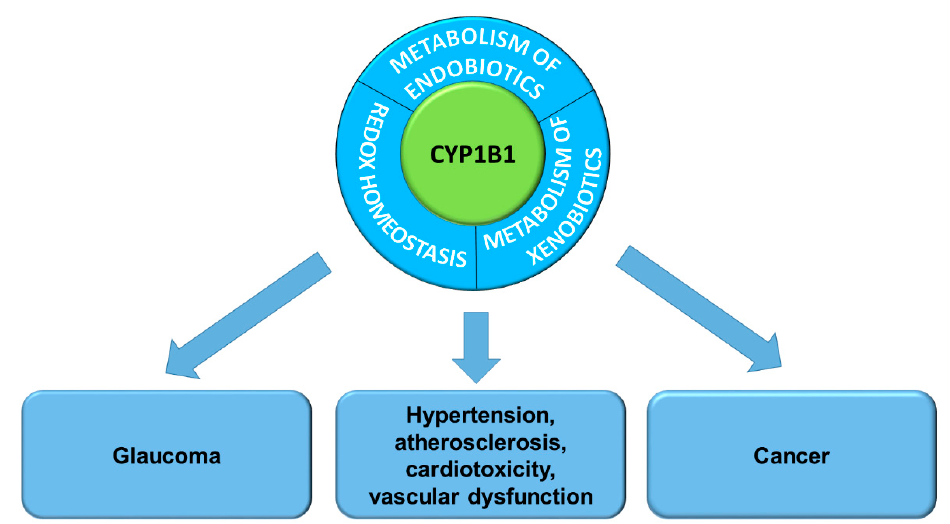
Figure 1. Cytochrome P450 1B1 functions and its association with pathogenesis of diseases. CYP1s are induced by agonists of the aryl hydrocarbon receptor (AhR), including polychlorinated dioxins with strong inducer 2,3,7,8-tetrachlorodibenzo-p-dioxin (TCDD) and polycyclic aromatic hydrocarbons [12,13]. The role of AhR as a transcription factor is not limited to the metabolism of xenobiotics. The AhR transduction pathway is also acti- vated by endogenous compounds, which include the products of metabolism of polyun- saturated fatty acids and heme, and by endobiotics—ligands which are produced in the gastrointestinal tract and skin [14,15].